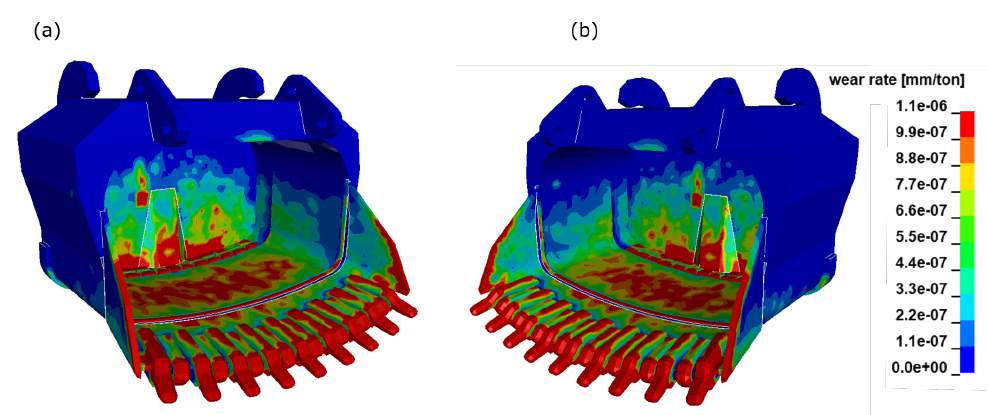
Figure 17. Overview of the predicted wear from simulations. View from ( a ) left, and ( b ) right. The color plots are in units mm/ton.